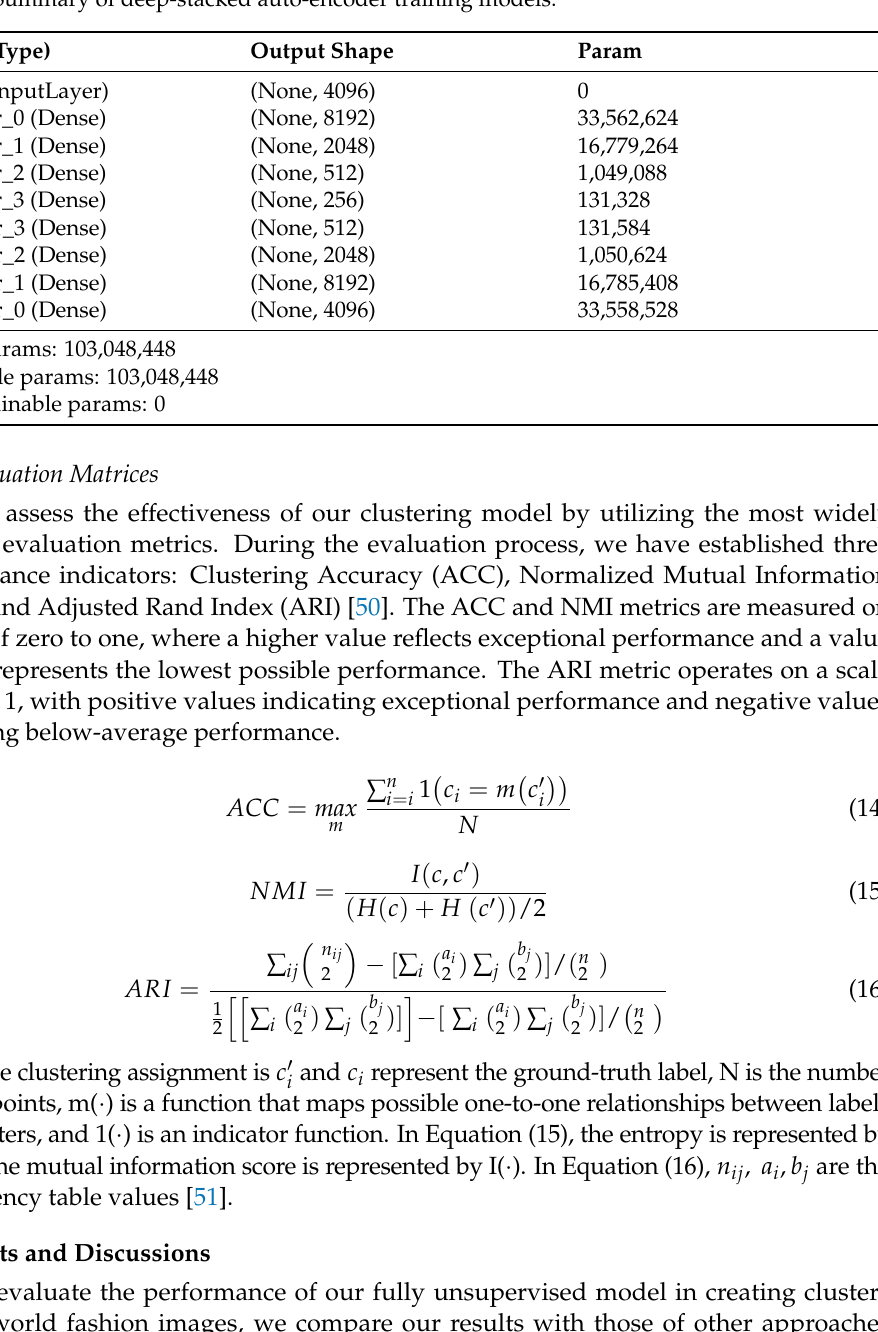
Table 3. Summary of deep-stacked auto-encoder training